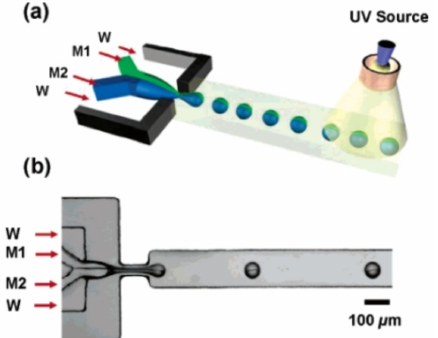
Figure 2. ( a ) Schematic of the generation of Janus droplets from immiscible monomers M1 and M2, emulsified in an aqueous solution of SDS (W). The droplets are irradiated with UV light in the downstream channel. ( b ) Optical microscopy image of the formation of Janus droplets. M1, M2, and W flow rates are 0.02, 0.02, and 4 mL/h, respectively. Reprinted with permission from ref. [62]. Copyright © 2006 American Chemical Society.